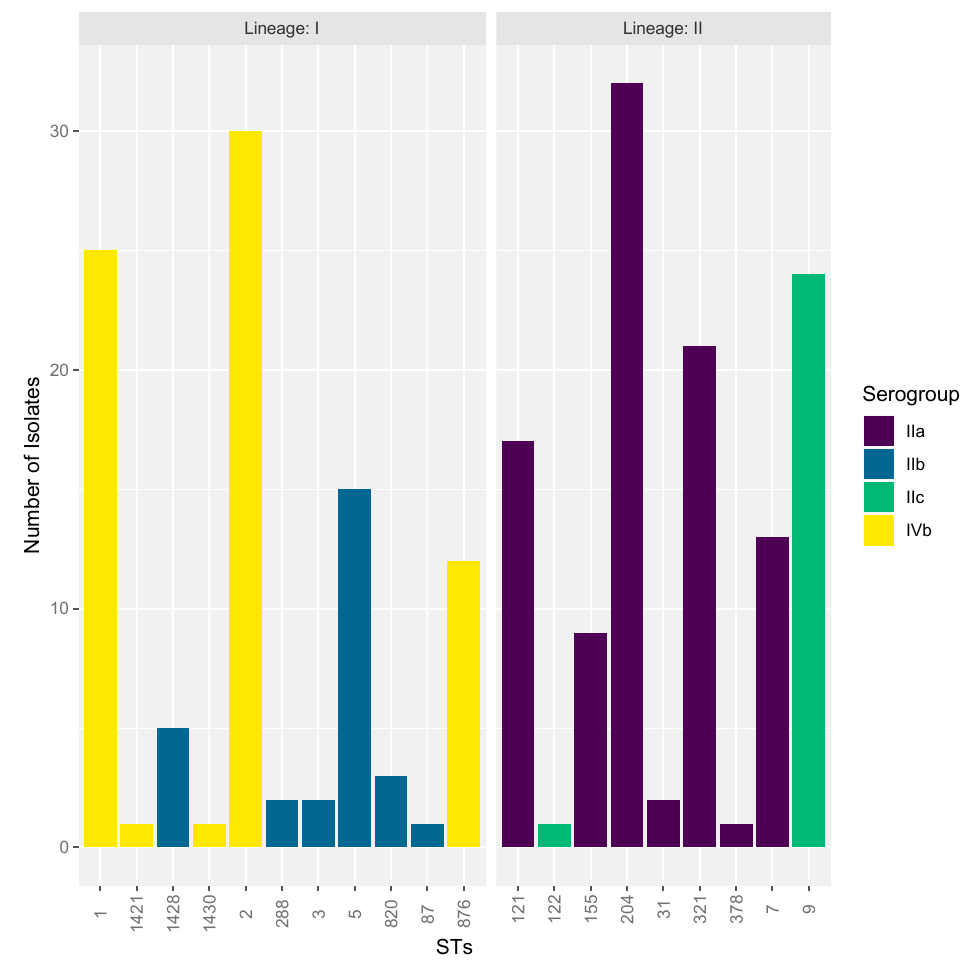
Figure 1. Lineage, serogroup, and sequence type distribution of Listeria monocytogenes isolates .